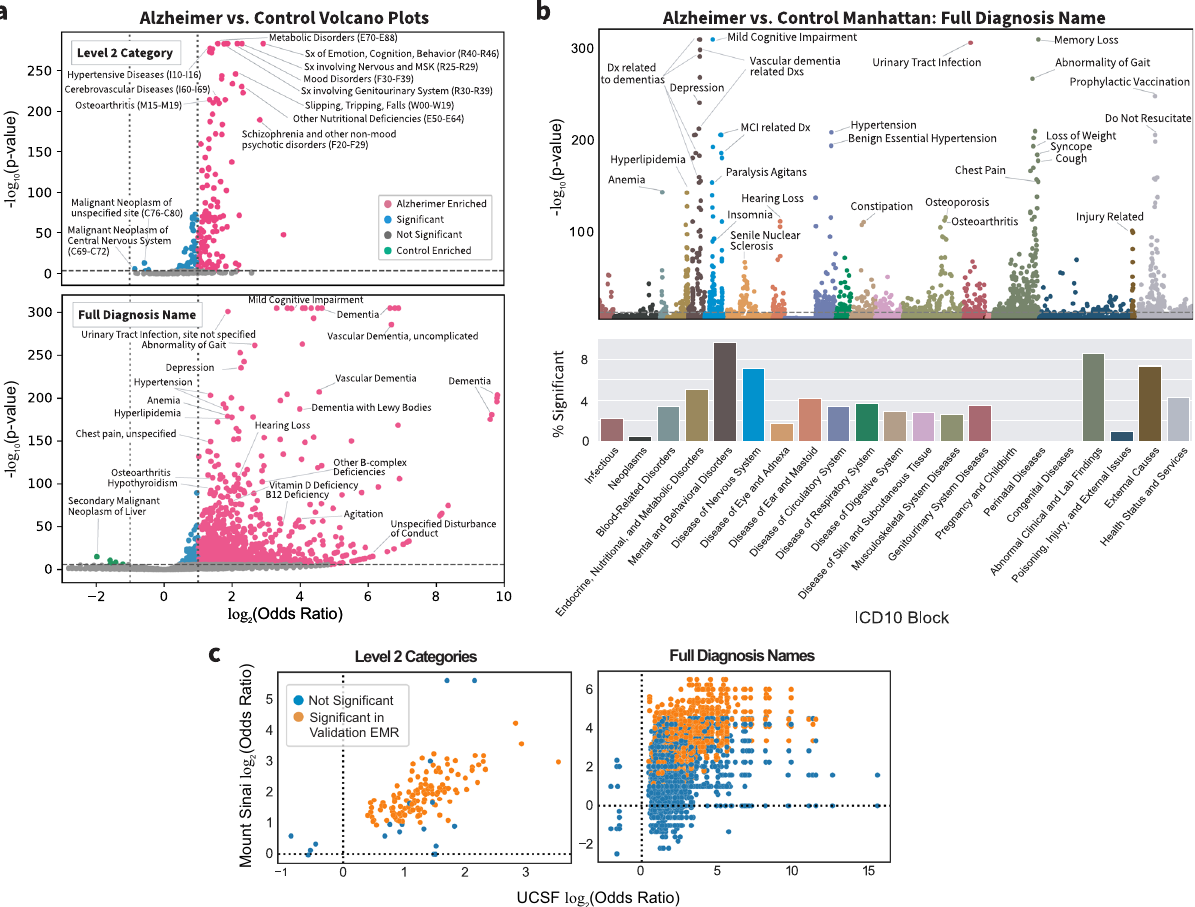
Fig. 4 Comorbidity enrichment analysis identi fi es enriched diagnosis in AD vs. control cohorts. a Volcano plot for Level 2 categories (top) and full diagnosis names (bottom) compared between AD and control cohorts using two-sided Fisher ’ s exact or Chi-squared test. p -value cutoff is Bonferroni- corrected ( p -value < 2e − 8 and 1e − 6) with log2 odds ratio cutoff of 1 for AD-enriched (pink) or log2 odds ratio cutoff of − 1 for control-enriched (green) and remaining signi fi cant diagnoses in blue. Some of the top signi fi cant diagnoses are labeled. b Top, a Manhattan plot with full diagnosis names colored by ICD-10-CM categories with signi fi cance determined by two-sided Fisher ’ s exact or Chi-squared test with Bonferroni-corrected p -value threshold of 0.05. Some of the top diagnoses in each category are labeled. Bottom, the percentage of diagnosis in each ICD-10-CM category is signi fi cant. c Diagnosis AD vs. control odds ratio correlation plots between UCSF and Mount Sinai for Level 2 diagnosis categories and full diagnosis names that are signi fi cant at UCSF (two-sided Fisher ’ s exact or Chi-squared test, Bonferroni-corrected p -value threshold of 0.05). Each dot represents a category or diagnosis, and dots in orange are signi fi cant at Mount Sinai with (two-sided Fisher ’ s exact or Chi-squared test with Bonferroni-corrected p -value threshold of 0.05 based on the number of signi fi cant UCSF